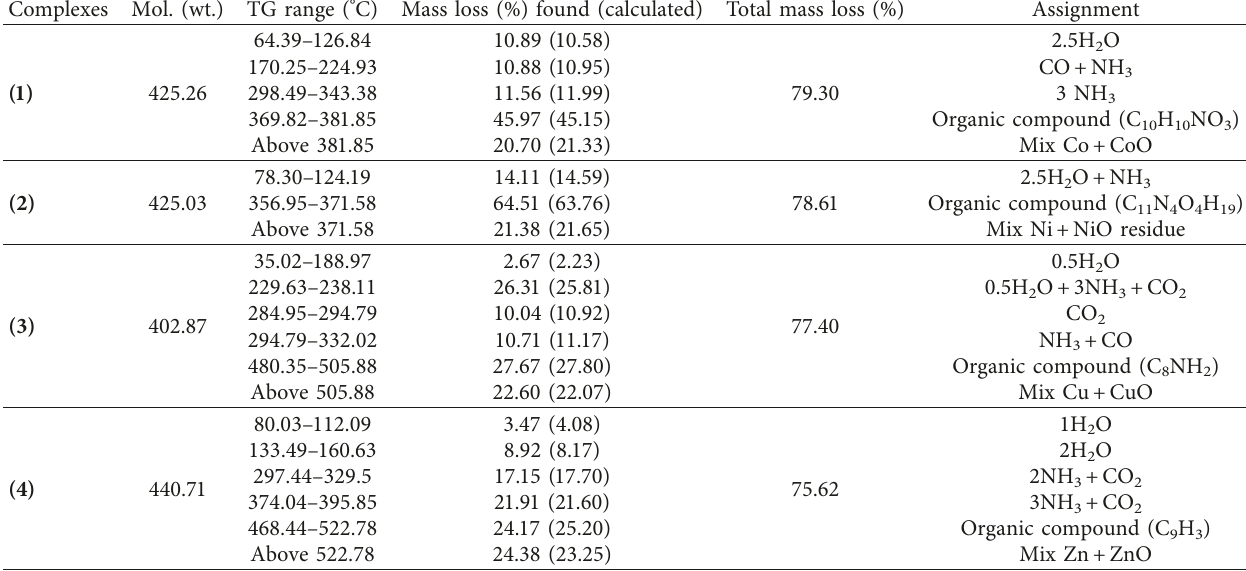
Figure 6: TG and DTG of (a) [Co(glu)(arg)(H (d) [Zn · Glu · Arg · (H 2 O) 2 ] · H 2 Table 5: Thermogravimetric analysis decomposition data for the metal ternary complexes.